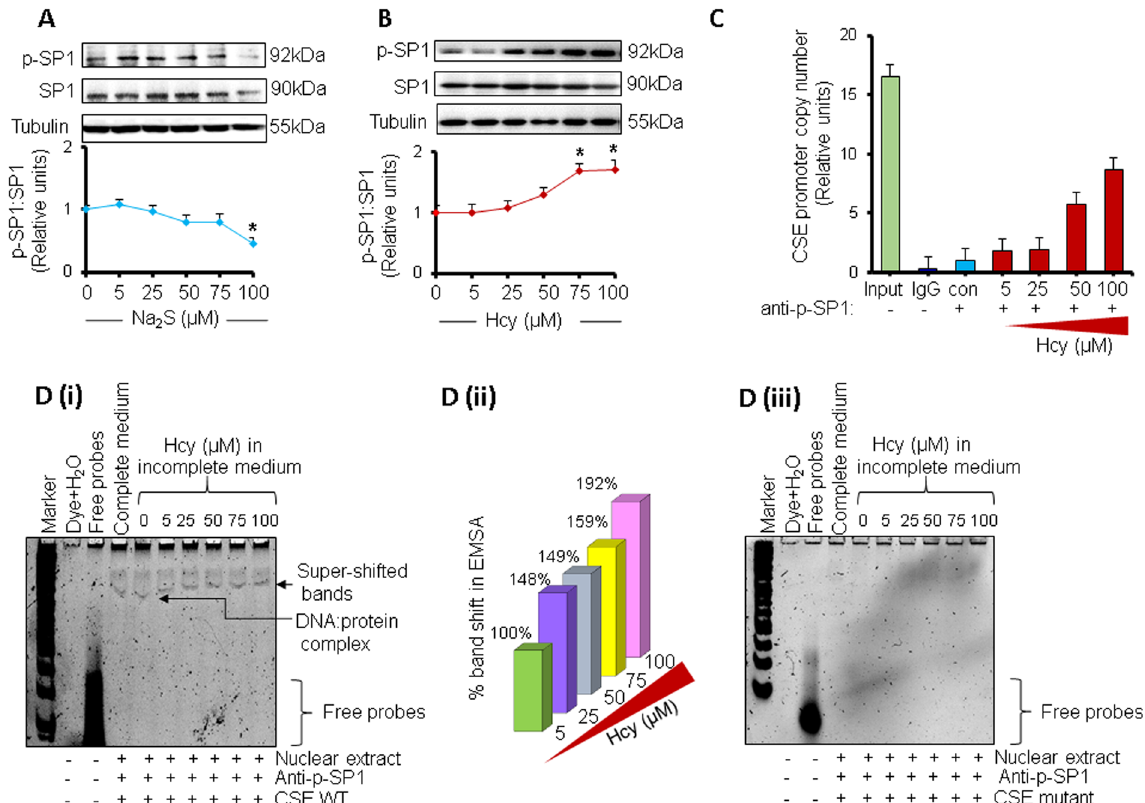
Figure 2. Effect of H 2 S or Hcy on SP1 activity in HL1 cardiomyocytes. ( A ) Western blot and densitometric analyses showing the activity of SP1 (p-SP1: SP1) in cardiomyocytes treated with different doses of Na 2 S or ( B ) Hcy. ( C ) Chromatin immunoprecipitation-qPCR assay showing amplification of CSE promoter copy number in cardiomyocytes treated with different doses of Hcy. ( D ) ( i ) Electrophoretic mobility shift assay showing WT CSE-SP-1 complex formation incubated with nuclear extracts from cardiomyocytes treated with different doses of Hcy. The super-shifted band represents binding of p-SP1 antibodies to the CSE-SP1 complex. ( D ) ( ii ) Quantification of percentage band shift in ‘D (i)’ in presence of p-SP1 antibody with different doses of Hcy. ( D ) ( iii ) Electrophoretic mobility shift assay (EMSA) showing no complex formation with mutant CSE-promoter. Values are represented as mean ± SEM. “ * ” represents statistically significant when compared to the untreated control. p < 0.05 is considered statistically significant. N =